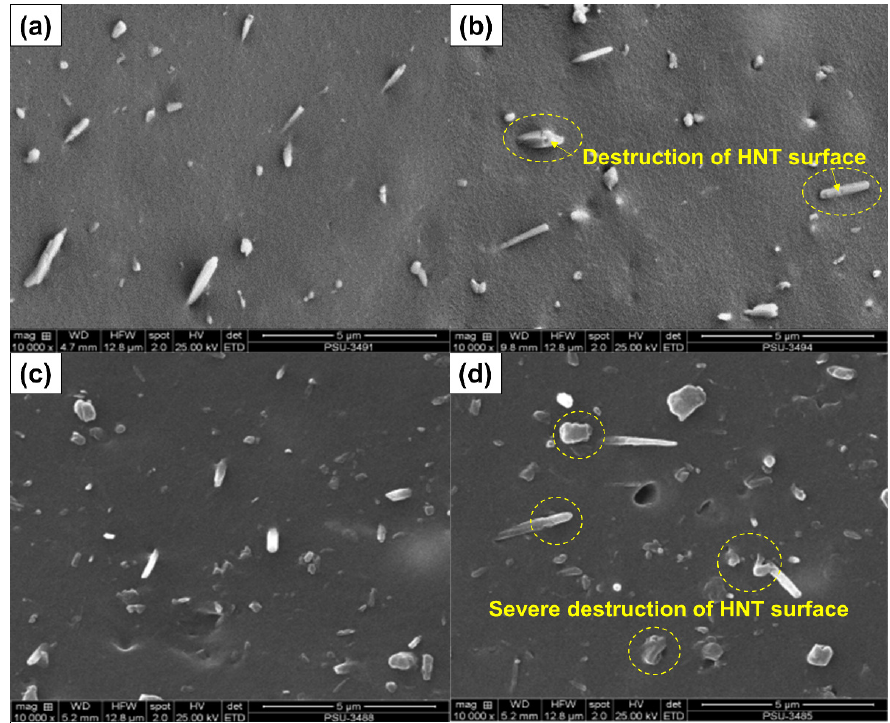
Figure 11. SEM photographs at 10,000× magnification of ENR/HNT composites filled with untreated and acid-treated HNT: E20 ( a ), E20A4 ( b ), E20A6 ( c ), and E20A8 ( d ).